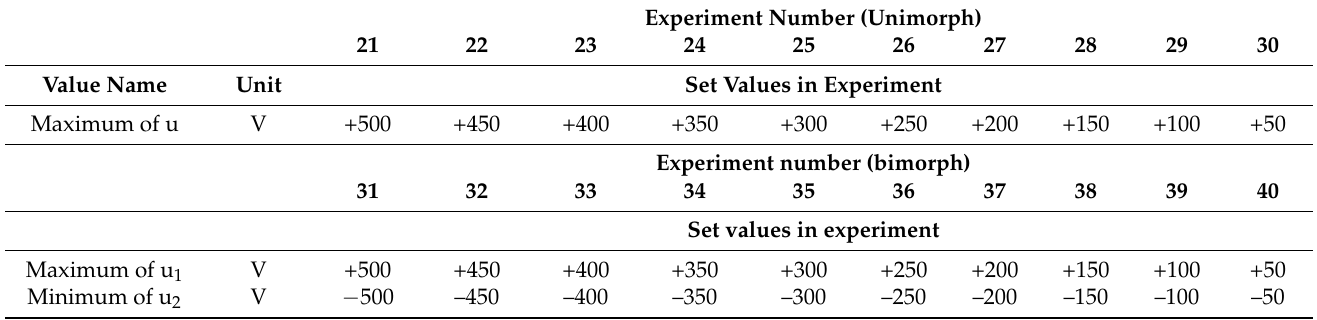
Table 3. Maximum and minimum values of input voltages in laboratory experiments 21 to 40.